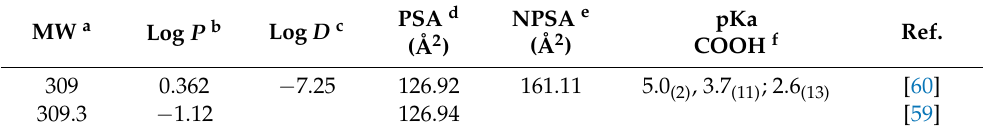
Table 2. Physicochemical properties of